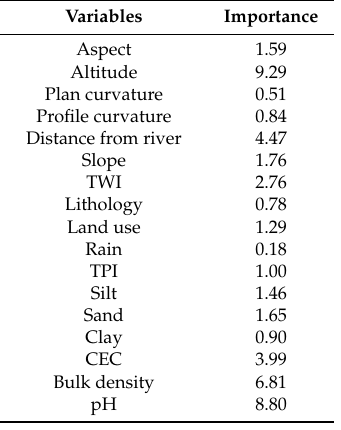
Table 5. Variable importance analysis.